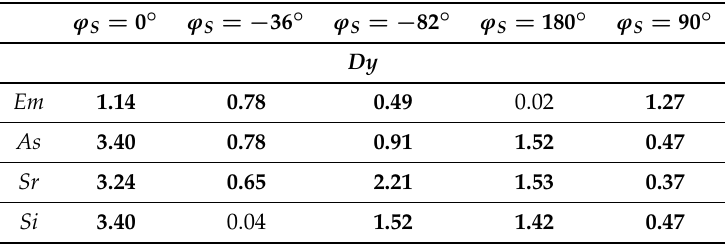
Table 2. p -values (Wilcoxon signed-rank test with Bonferroni–Holm correction) for ratings of distance. Insignificant differences ( p -values ≥ 0.05) are indicated by bold numbers.